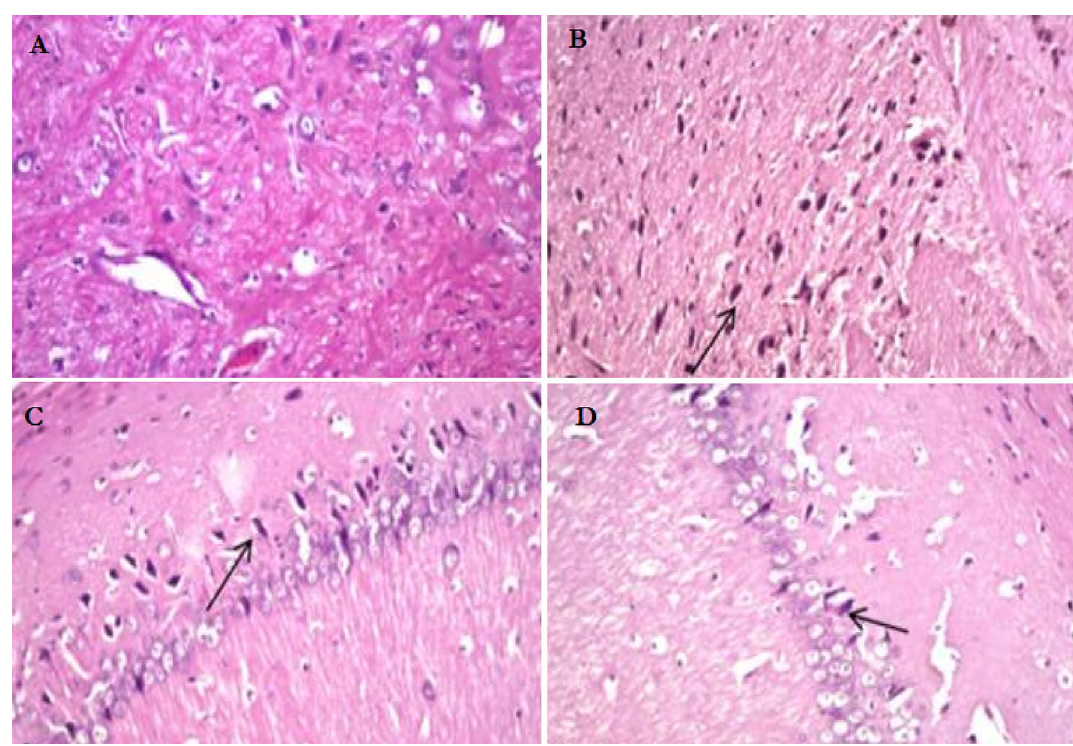
Figure 9. Impact of gallic acid on the cerebrum of CdCl 2 -induced neurotoxic rats (H & E, 200X). Group A (Control rats), Group B (cadmium chloride-treated rats), Group C (CdCl 2 + GA-treated rats), Group D (gallic acid-treated rats) ( A ) Control showing normal granular layer, molecular layer, purkinje cell layer, blood vessels as well as while matter. ( B ) CdCl 2 group showing severe vacuolation of purkinje cell layer, optical empty spaces due to necrosis (arrow), severe separation of purkinje cell layer from granular layer, severe hemorrhage of white matter; ( C ) CdCl 2 + GA group showing vacuolated purkinje cell layer (black arrow), mild separation of purkinje cell layer; ( D ) GA group reveals normal granular layer, molecular layer, vacuolated purkinje cell layer (black